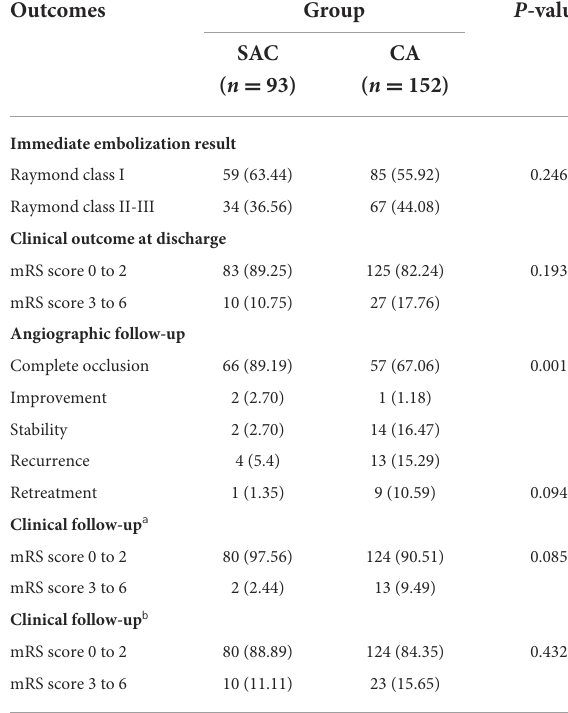
TABLE 2 Angiographic and clinical outcomes for patients treated with SAC and